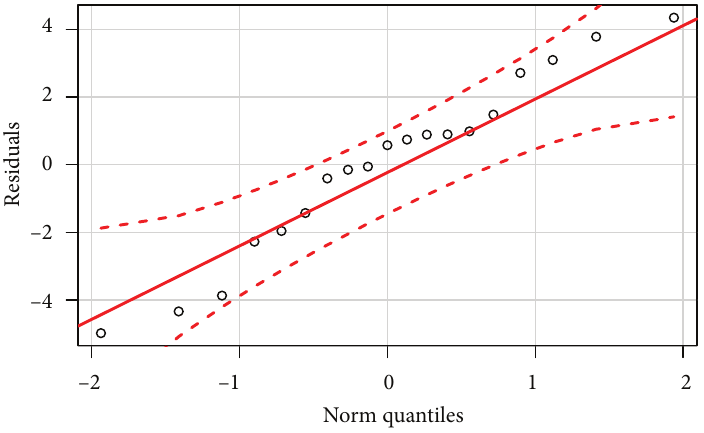
Figure 1. Q – Q plot for a linear regression model (source: own data processing in R program)